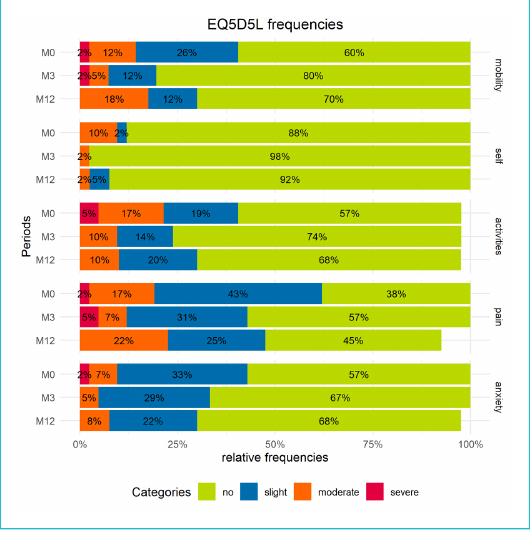
Figure 4: Distribution frequencies of problems on EQ-5D-5L di- mensions for first evaluation (M0), 3-month follow-up (M3) and 12-month follow-up (M12). The categories are mobility ("mobility"), self-care ("self"), usual activities ("activities"), pain and discomfort ("pain") and anxiety and depression ("anxiety"). Values are pre- sented as percentages of total responses for “no, slight, moderate and severe problems”.